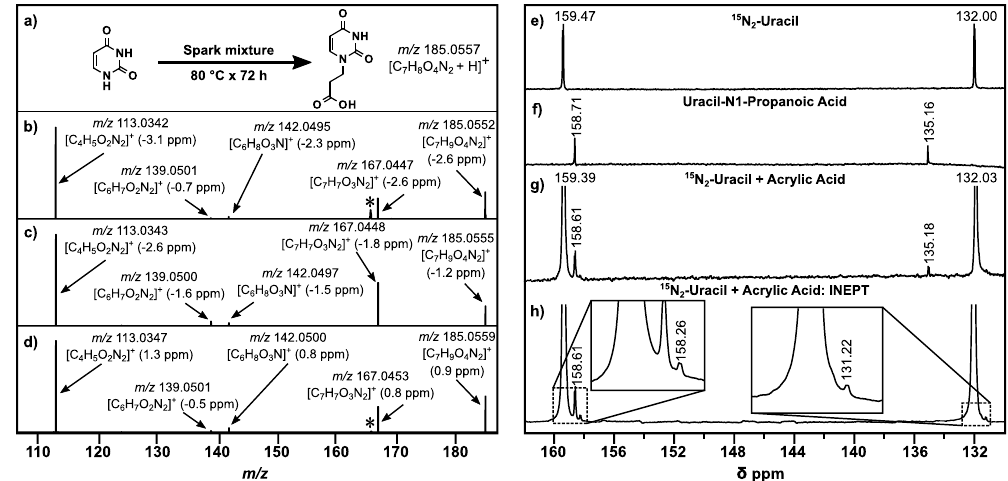
Figure 1. Elucidating the structure and formation of the major adduct formed in uracil-spark mixtures. Note that relative mass error given in ppm is calculated as 10 6 × ( mass experimental − mass theoretical )/( mass theoretical ). ( a ) depicts the adduct ( m/z 185.0552) identified from DART-MS analysis of uracil incubated with a Miller-Urey spark discharge mixture generated under a reducing atmosphere (0.4 N 2 , 0.1 CO 2 , 0.25 CH 4 , 0.25 H 2 ). ( b , c ) show the product ion spectra (MS/MS) of the precursor ion ( m/z 185.05) at 40% collision energy (14 eV) isolated from uracil incubated with: ( b ) spark mixture and ( c ) acrylic acid. ( d ) shows the MS/MS of uracil-N1-propanoic acid standard. The * indicates an instrument artifact. ( e–h ) 15 N-NMR results confirm that acrylic acid adds preferentially to the N1 position of uracil. ( e ) 15 N 2 -Uracil produces two doublets corresponding to N1 ( δ 132.00) and N3 ( δ 159.47). ( f ) Uracil-N1-propanoic acid standard shows that addition at the N1 position shifts the N1 peak downfield ( δ 135.16) and N3 peak upfield ( δ 158.71). ( g ) The four peaks produced from 15 N 2 -Uracil incubated with acrylic acid (100 °C x 3 h in D 6 -dimethyl sulfoxide (D 6 -DMSO)) correspond to uracil and uracil-N1-propanoic acid. ( h ) INEPT spectrum of the reaction mixture shows peaks only for nitrogens that have protons directly attached; the N1 peak peaks ( δ 158.26 and δ 131.22), suggests that the C5 adduct is a minor product in this reaction. The tops of